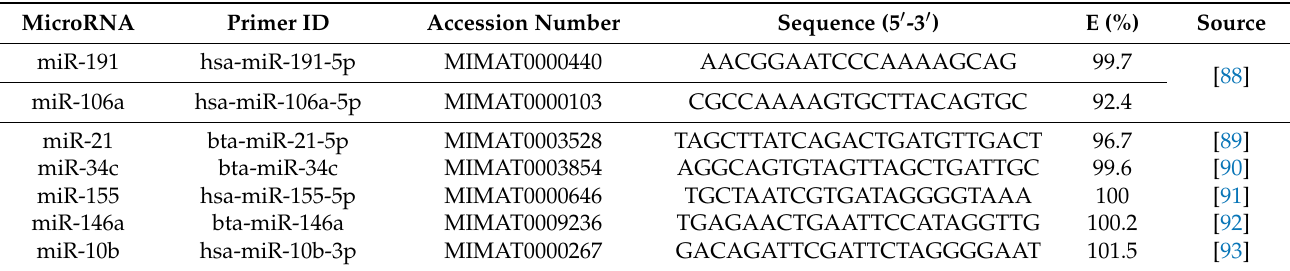
Table 1. MicroRNA primers for qPCR.